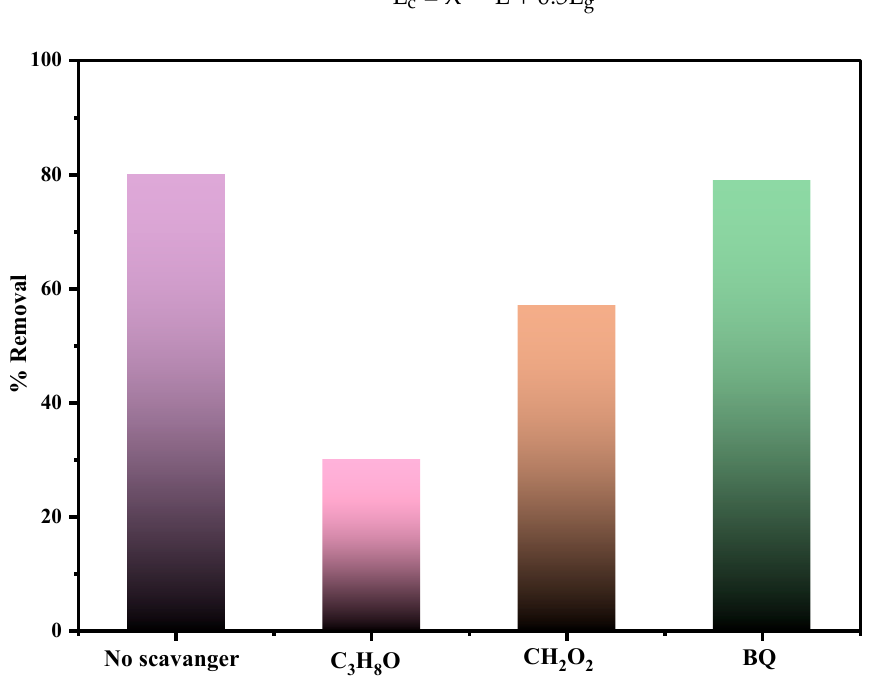
Figure 10. MB Photocatalytic degradation by 0.5PBB composite upon solar light irradiation in the presence of scavengers (C 3 H 8 , CH 2 O 2 , and BQ).